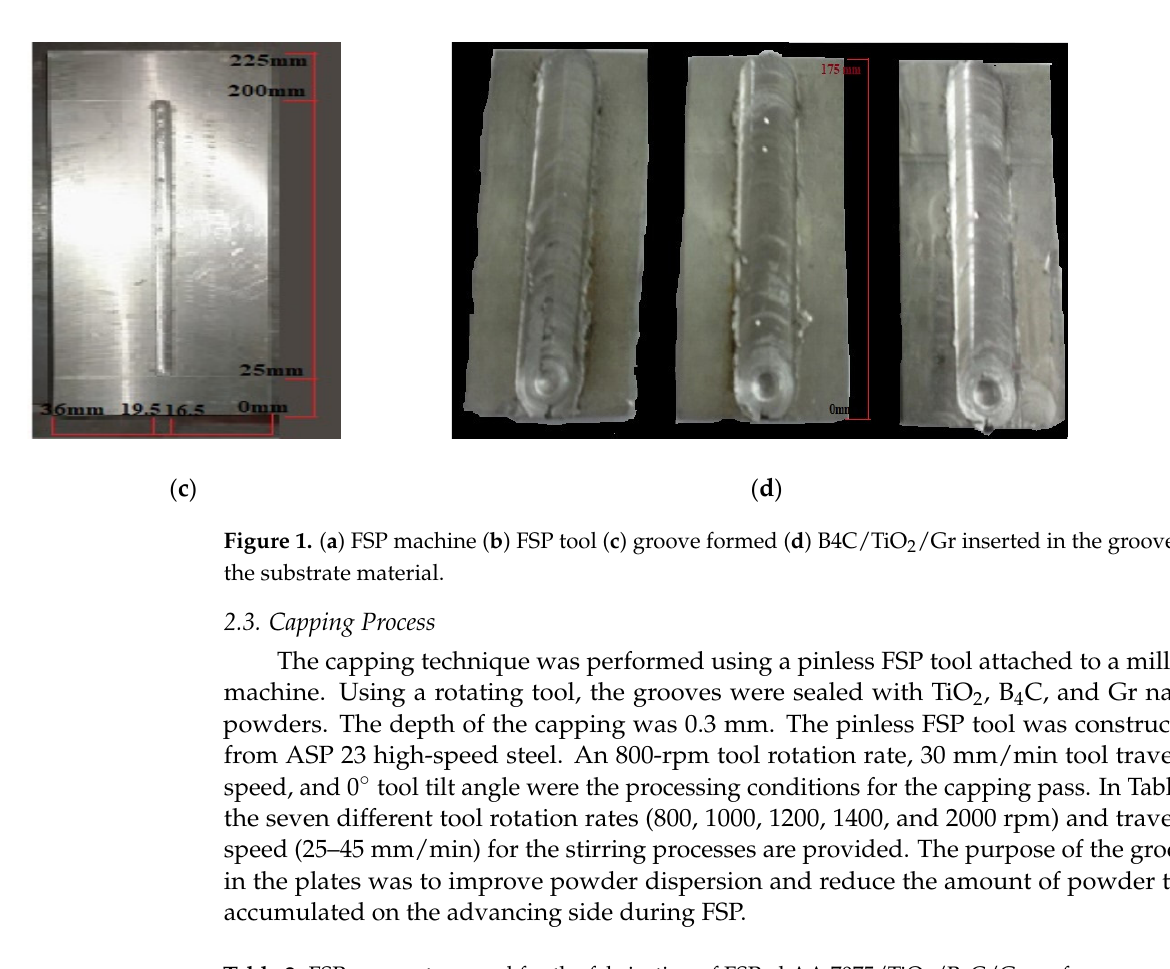
Table 2. FSP parameters used for the fabrication of FSPed AA 7075/TiO 2 /B 4 C/Gr surface composite specimens.